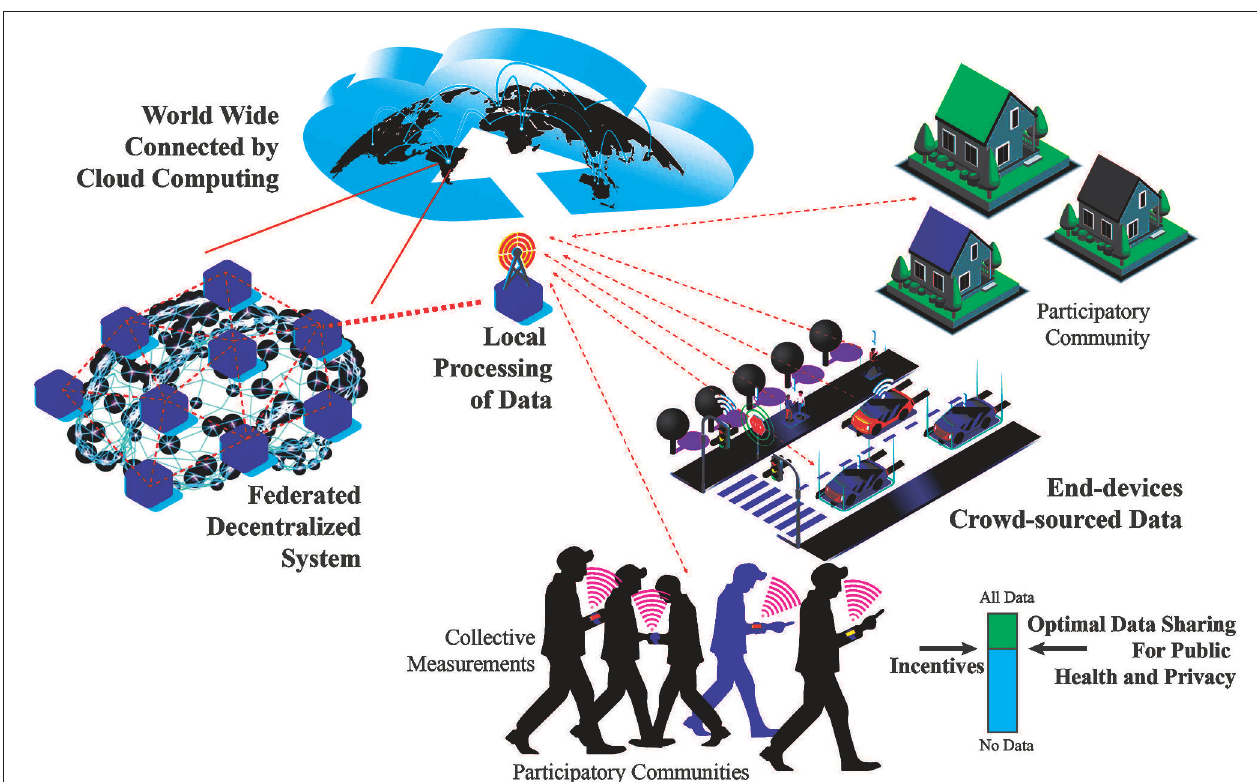
FIGURE 1 | A federated ubiquitous systems for epidemiological warning and response. An organic and bottom-up scaling at global level is envisioned based on active citizens’ participation. Decentralized privacy-preserving computations are performed from the edge to the cloud based on crowd-sourced obfuscated and anonymized data managed with distributed ledgers to empower trust. Incentive mechanisms for responsible data sharing align the public health mandate with citizens’ privacy and autonomy.